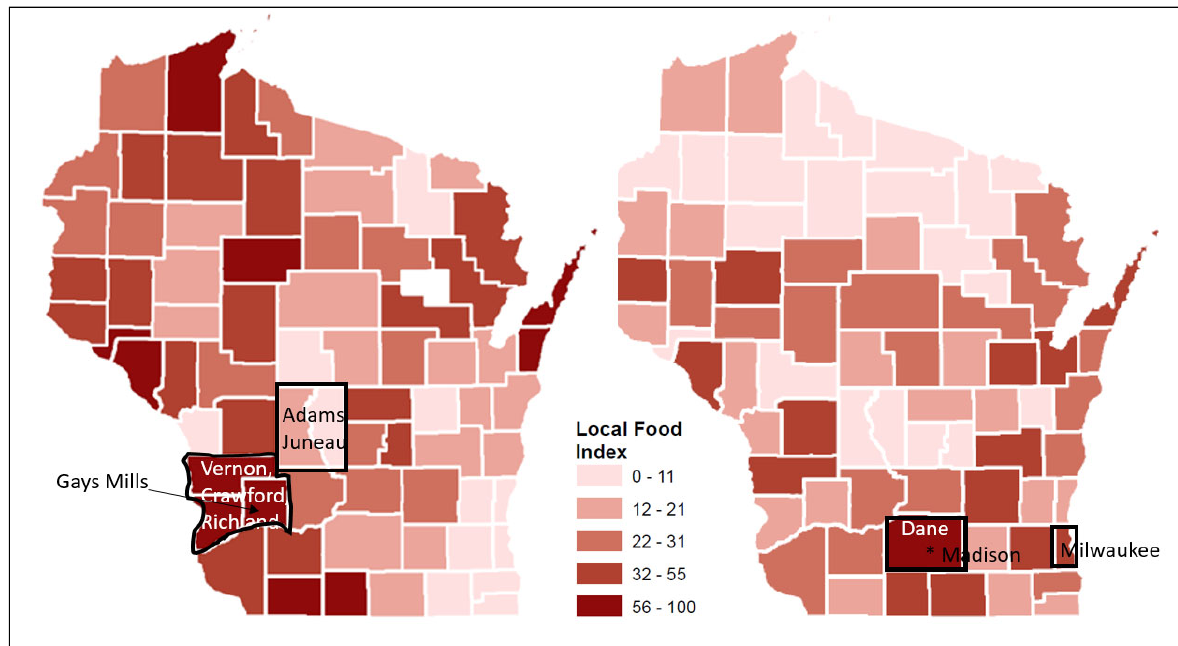
Figure 1. Wisconsin Local Food Index and Case